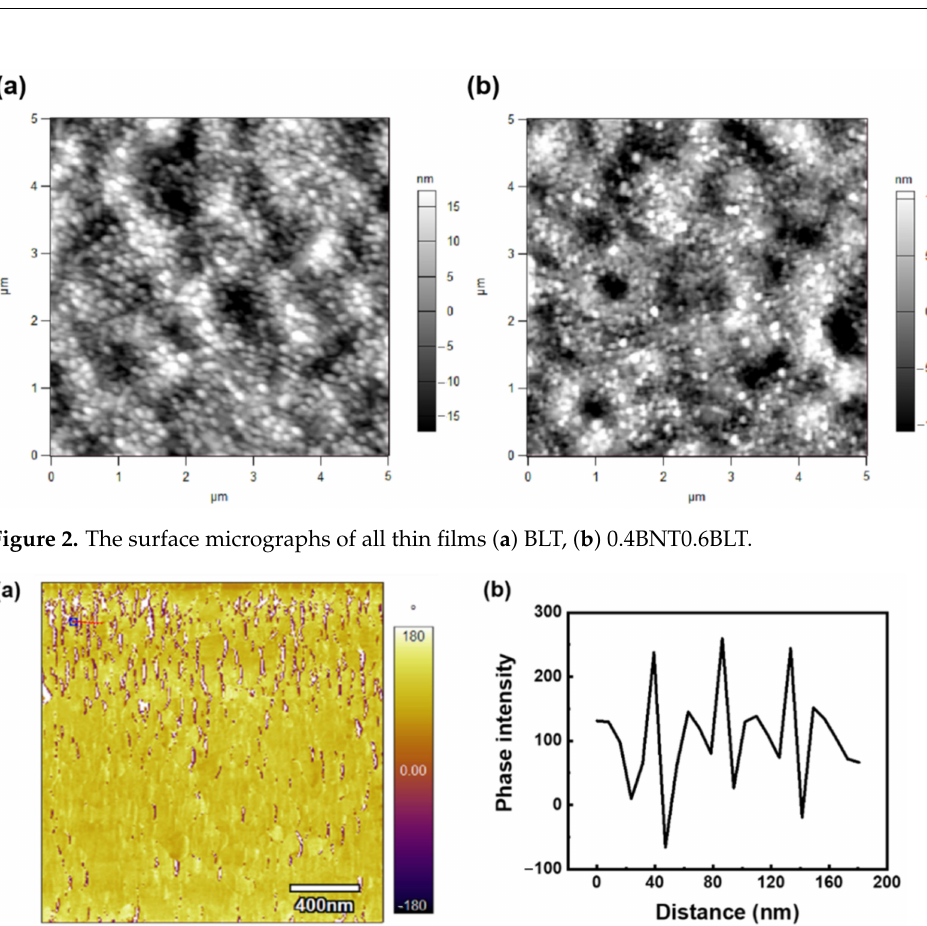
Figure 3. PFM images of 0.4BNT-0.6BLT; ( a ) Phase image of 0.4BNT-0.6BLT with 2 × 2 µ m 2 scanning area; ( b ) the phase diagram of the cross-section in ( a